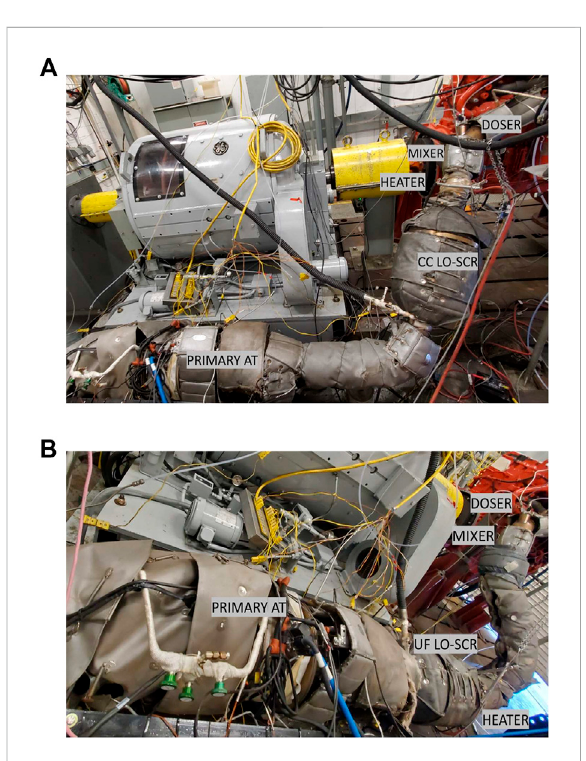
FIGURE 2 (A) Fully insulated aftertreatment system with CC LO-SCR and EH. (B) Fully insulated aftertreatment system with UF LO-SCR.